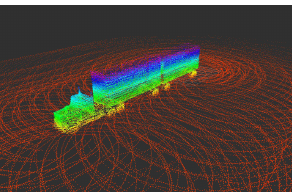
Figure 27. Truck 3D map generated by graph